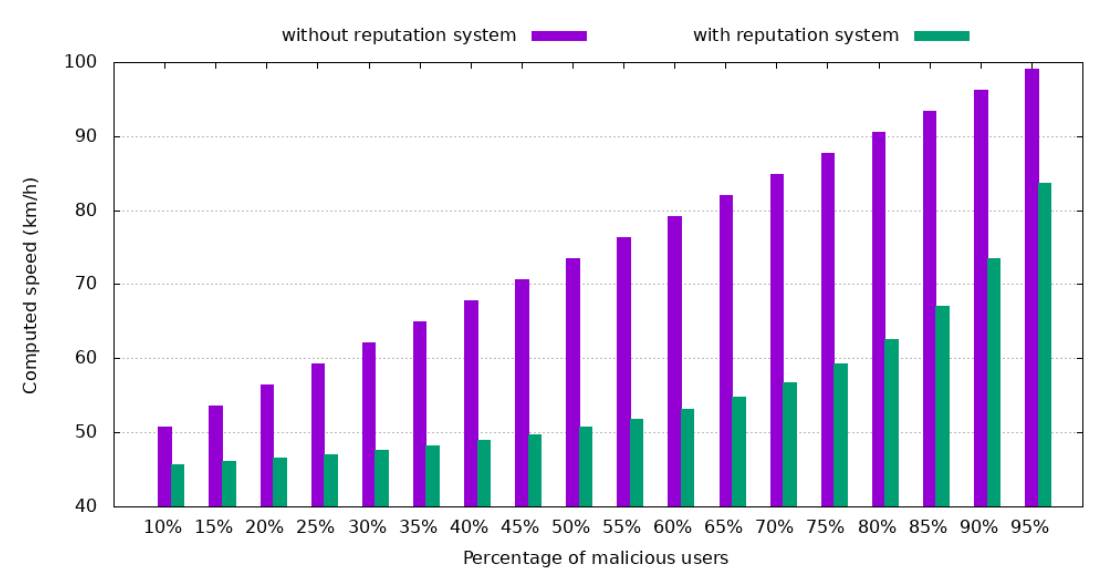
Figure 19. Impact of malicious users reporting higher